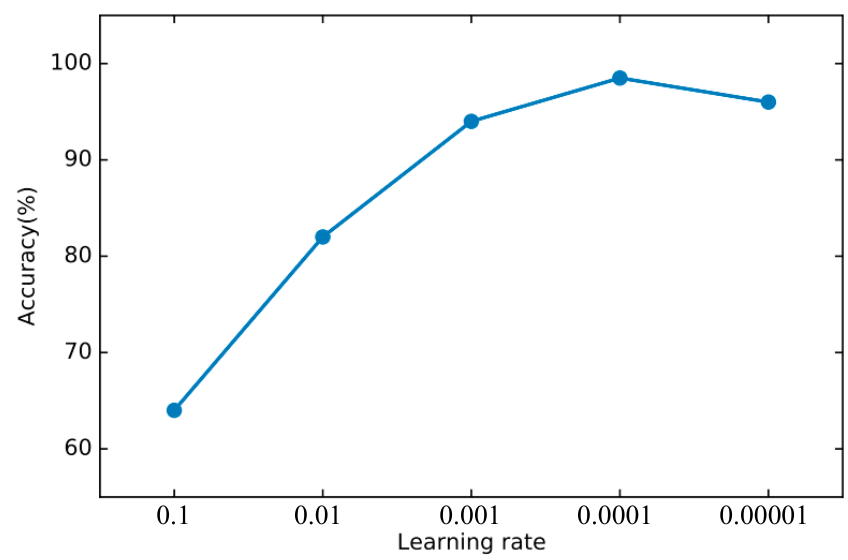
Figure 8. The accuracy of DNN changes when different learning rates are set.